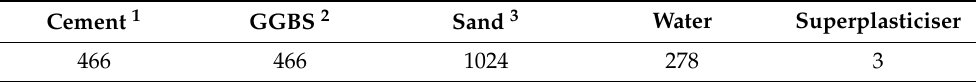
Table 2. Mixture composition of mortar for tensile test (KICT, unit: kg/m 3 ).